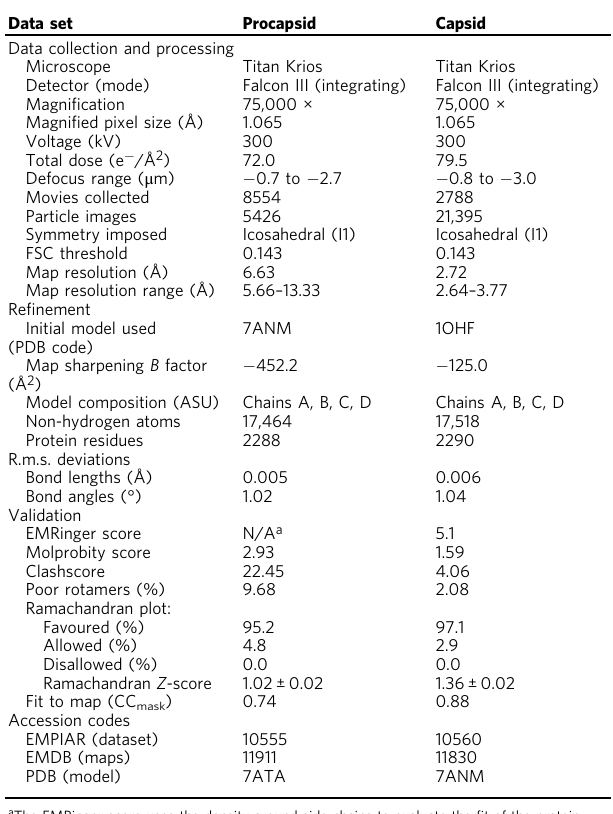
a The EMRinger score uses the density around side-chains to evaluate the fi t of the protein backbone. At a resolution of 6.6Å there is no discernible side-chain density and thus the EMRinger score is